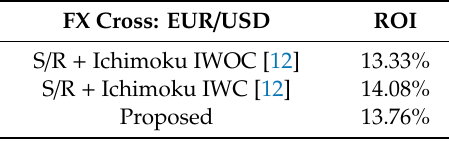
Table 3. Trading Performance